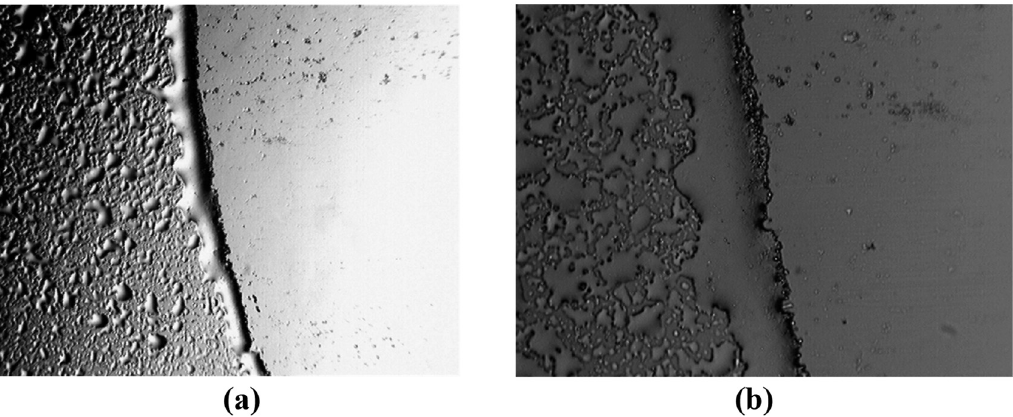
Figure 10: Microscope images of PMMA coating presented in Figure 9 after melting on a hot plate at ∼ 90°C with ( a ) × 40 and ( b ) × 100 magni fi cation. The images were taken on the edge of the deposition zone, where deposited material did not cover whole surface.